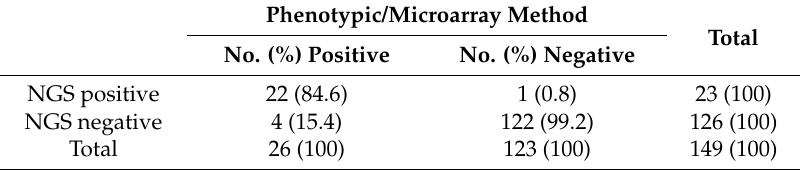
Table 1. Detection of CTX-M-15 ESBL genes by the amplicon-based next-generation sequencing method (NGS) on direct patient material, compared to conventional method (culture + CDT, followed by